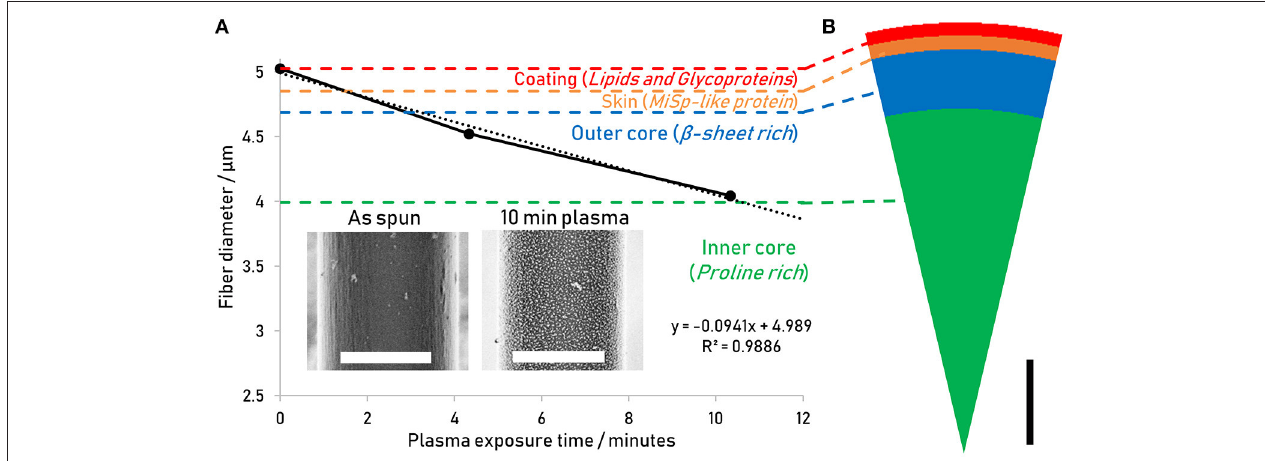
FIGURE 1 | (A) Reduction of diameter with increasing plasma treatment time. Different layers relative to the overall diameter are indicated according to Sponner et al. (2007) . Insets: Regular secondary electron images of Nephila inaurata dragline silk before and after 10min plasma treatment, imaged at 500eV. Scalebars measure